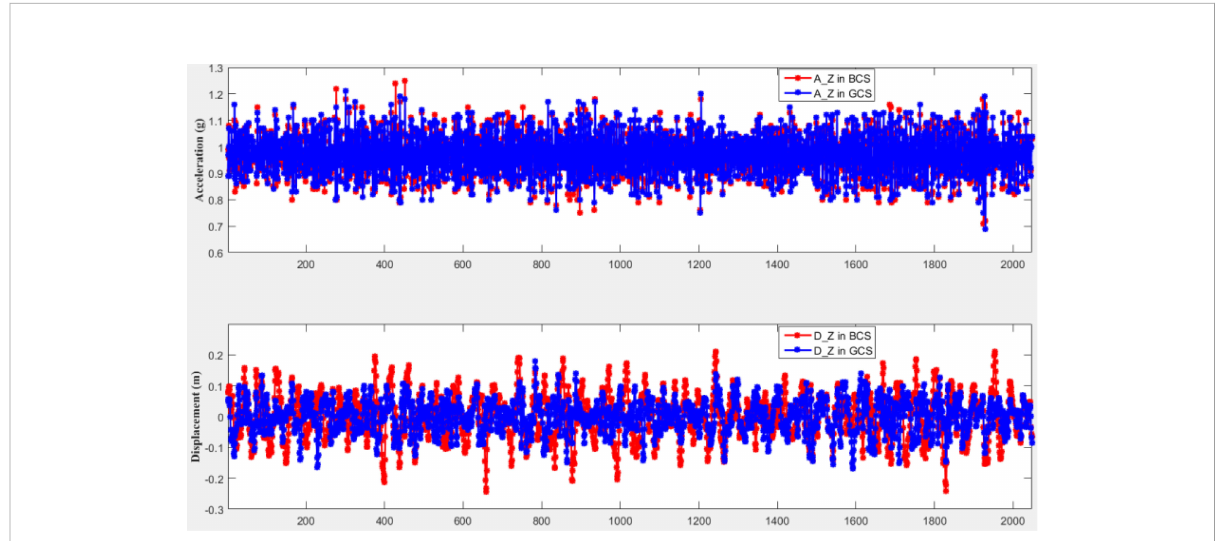
FIGURE 5 Comparison of accelerations and displacements before and after coordinate projection.